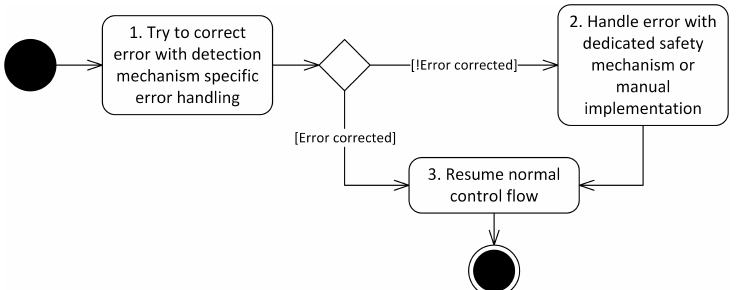
Figure 8. Runtime behavior of the error handling process (UML 2.5 activity diagram notation).